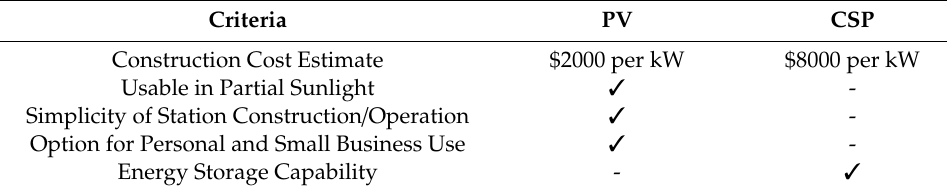
Table 1. Solar photovoltaic (PV) and concentrated solar power (CSP): comparison. Criteria PV CSP Construction Cost Estimate $2000 per kW $8000 per kW Usable in Partial Sunlight (cid:51) - Simplicity of Station Construction / Operation (cid:51) - Option for Personal and Small Business Use (cid:51) Energy Storage